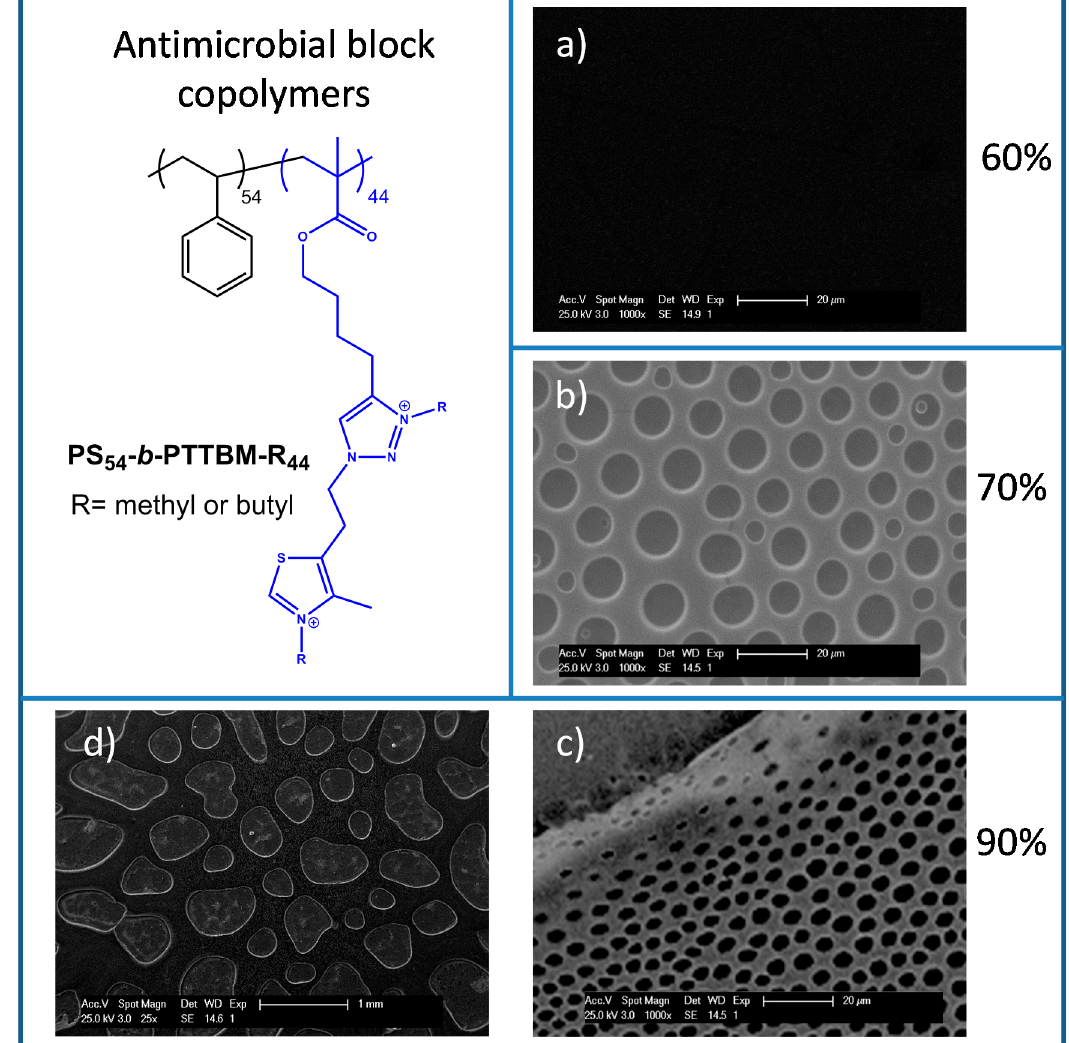
Figure 1. Chemical structure of the antimicrobial block copolymer quaternized with butyl (PS 54 - b -PTTBM-B 44 ) or methyl (PS 54 - b -PTTBM-M 44 ) iodides, and SEM images of the films of PS/PS 54 - b -PTTBM-B 44 blends, 97/3 wt % obtained from THF solutions at ( a ) 60%; ( b ) 70%; and ( c , d ) 90% relative humidity.